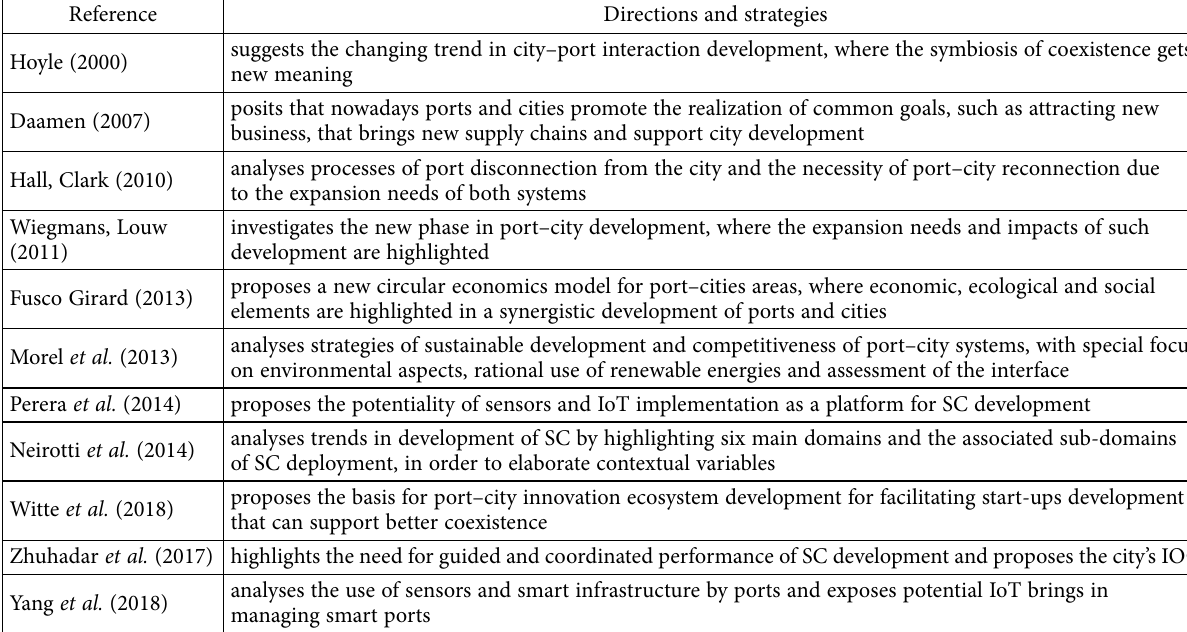
Table 1. Directions in SCP